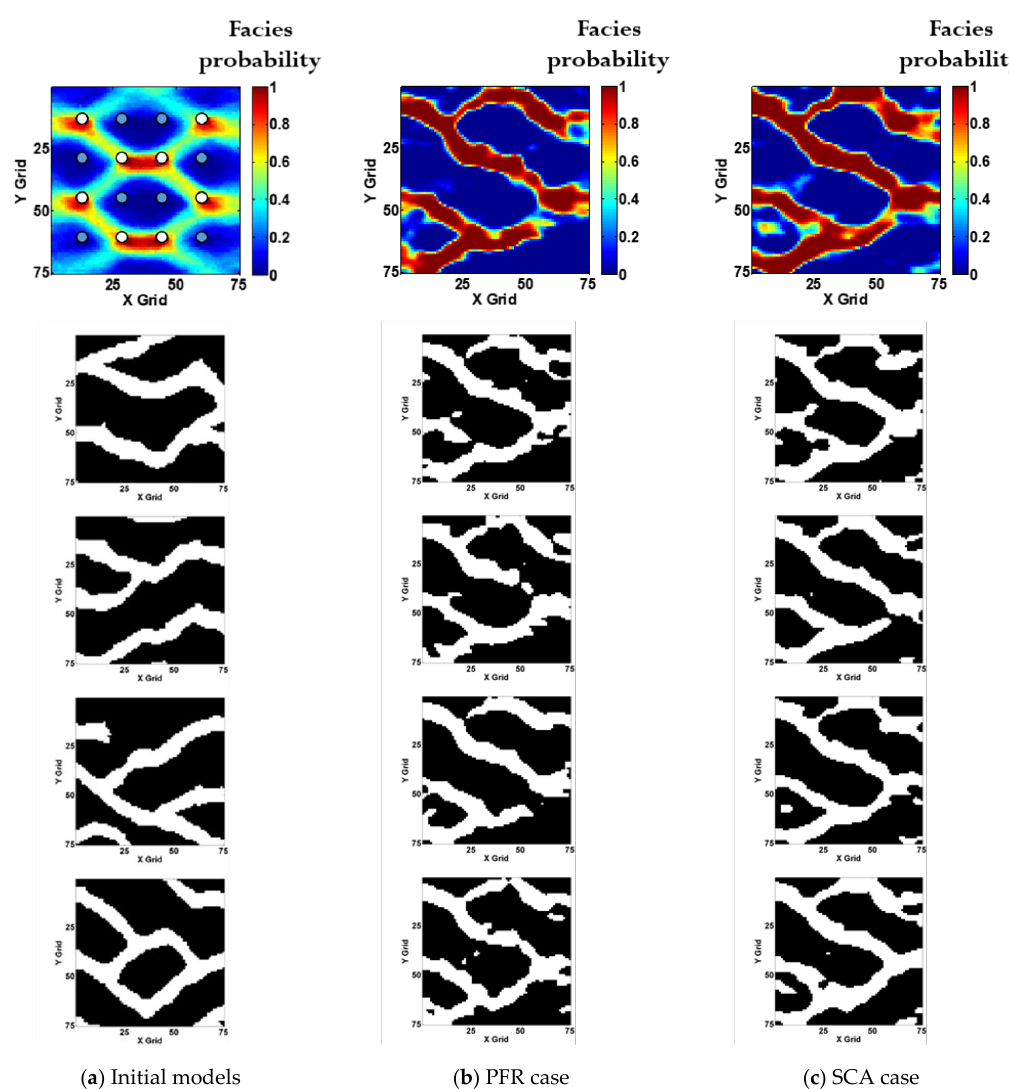
Figure 10. Comparison between final updated facies distribution using PFR and SCA: Averages of one hundred realizations of (a) initial models, updated models by (b) PFR and (c) SCA in the first row, and four example realizations below the first row.